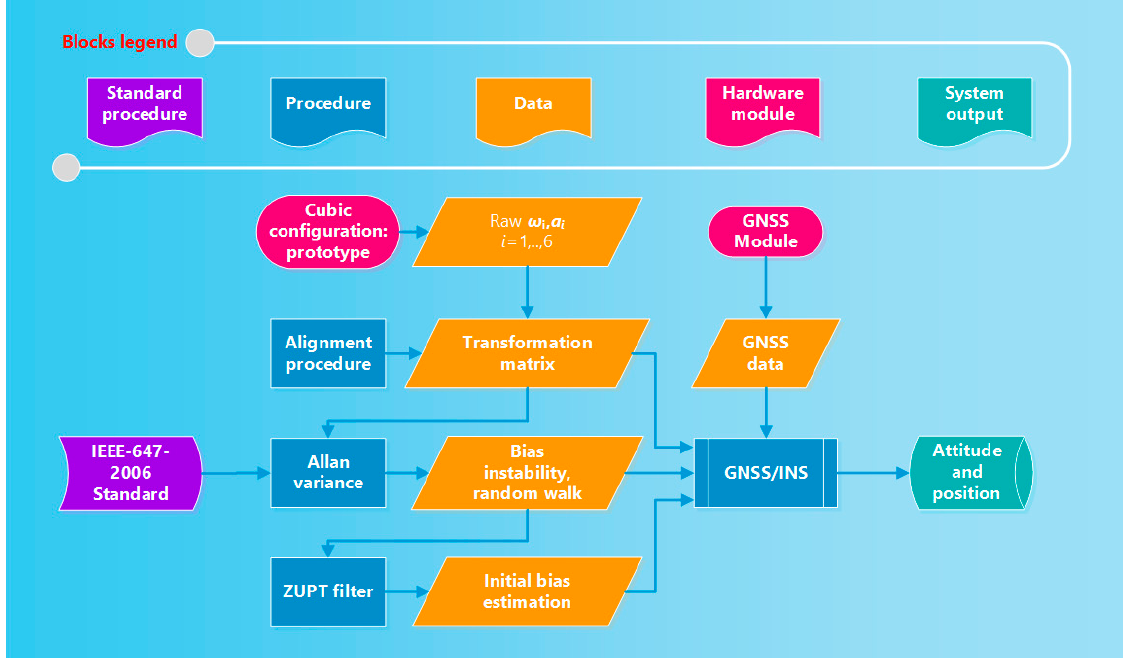
Figure 2. Flow chart of the measurement procedure.